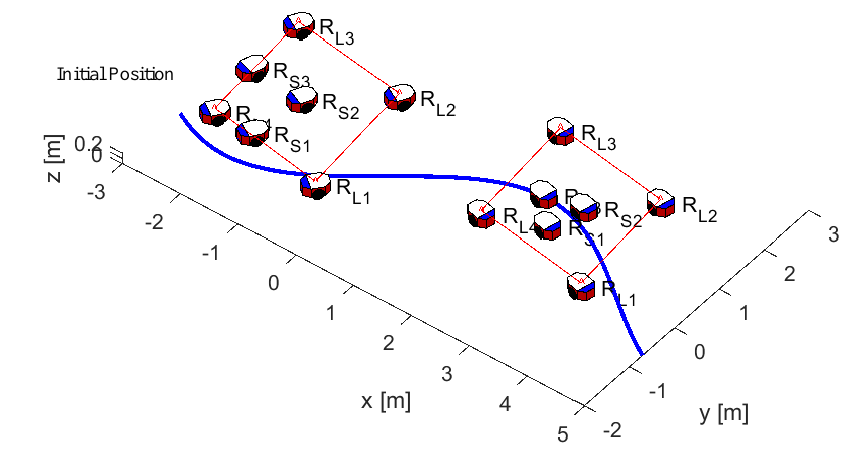
Figure 9. The trajectory of leader robots and follower robots